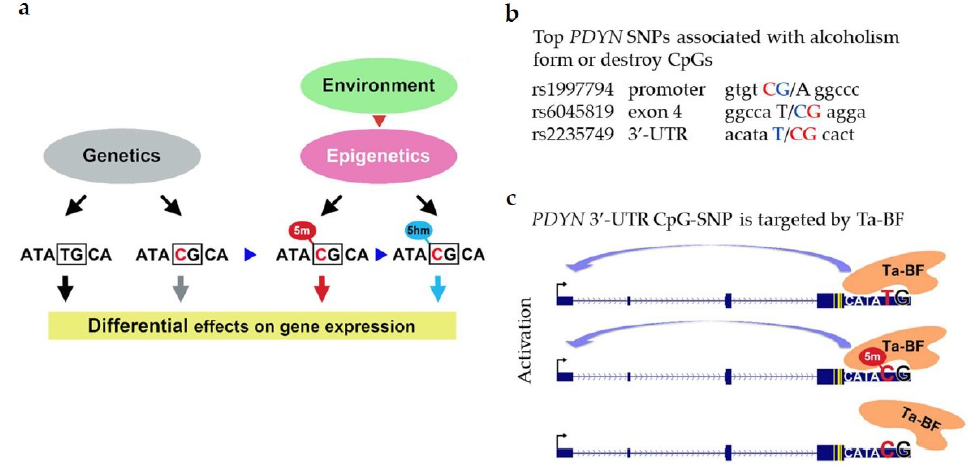
Figure 6. The CpG-SNP hypothesis . ( a ) Genetic, epigenetic and environmental factors are mechanistically integrated at CpG-SNPs that may be methylated and hydroxymethylated at the C-allele. Two alleles and three cytosine epialleles may differentially affect gene transcription and thereby differently contribute to deasease predisposition [89]. ( b ) PDYN SNPs variants associated with alcoholism are shown in blue while those forming CpGs in red . ( c ) T-allele-binding factor (Ta-BF) has high affinity for the T and methylated C alleles of the 3 ′ -UTR CpG-SNP but not to unmethylated C allele. The high affinity interaction may be a basis for transcriptional activation by this DNA-binding protein.